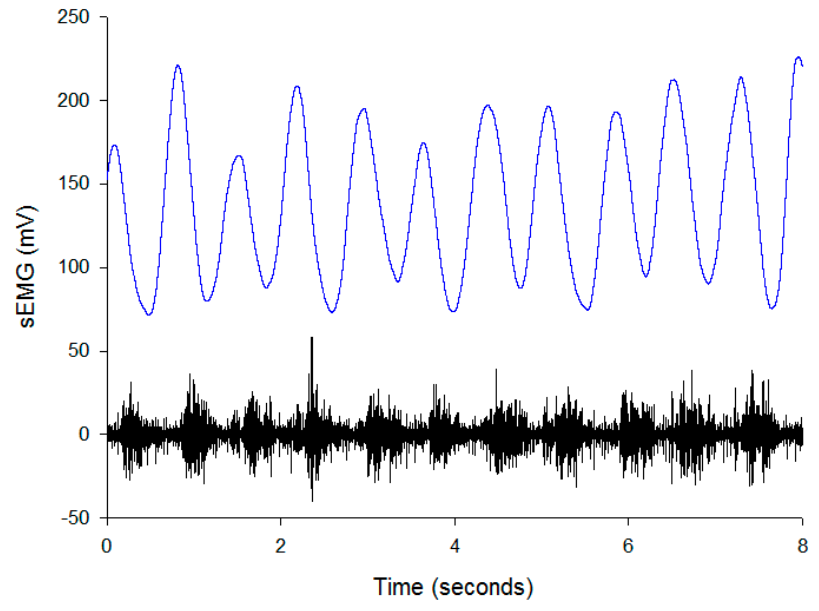
Figure 6. Surface electromyography (sEMG) (lower) and its envelope signals (upper).